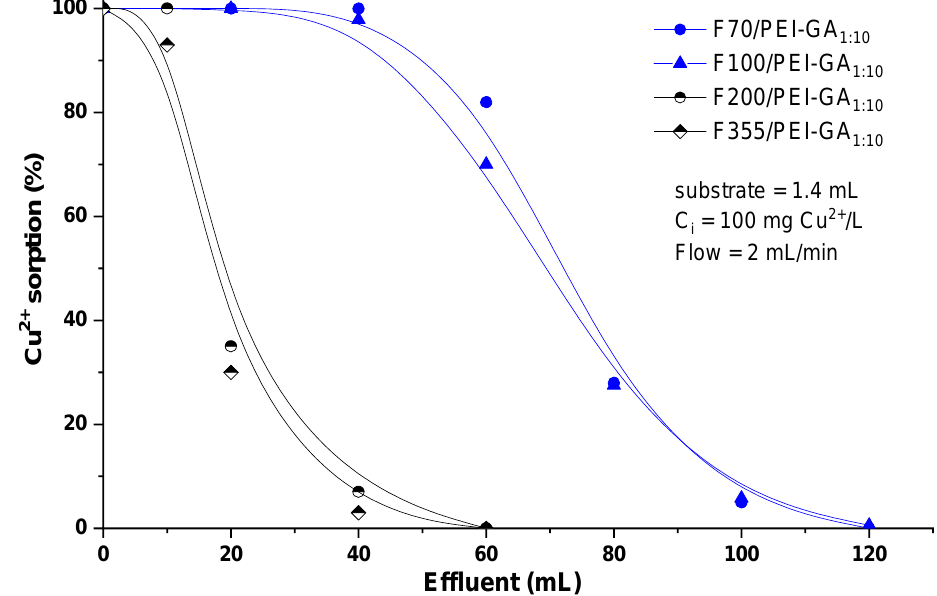
Figure 7. Sorbed amount (%) of Cu 2+ onto different sand composites with low cross-linking degree using a dynamic experiment in a column.